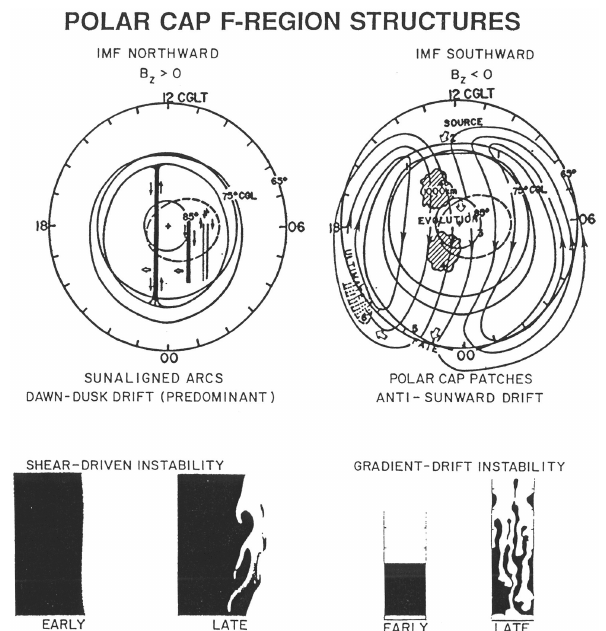
Fig. 1. Conditions characterizing the northward (top left) and south- ward (top right) IMF state of the polar cap ionosphere, after an ex- tended period dominated by respectively sun aligned arcs and polar cap patches (from Carlson, 1994). The process believed to dominate plasma structuring in sun aligned arcs is the shear driven instability illustrated in the lower left (Keskinen et al., 1988), while the pro- cess believed until 2007 to dominate patch structuring is illustrated in the lower right (Keskinen and Ossakow, 1983). The composite figure is adopted from Carlson et al.